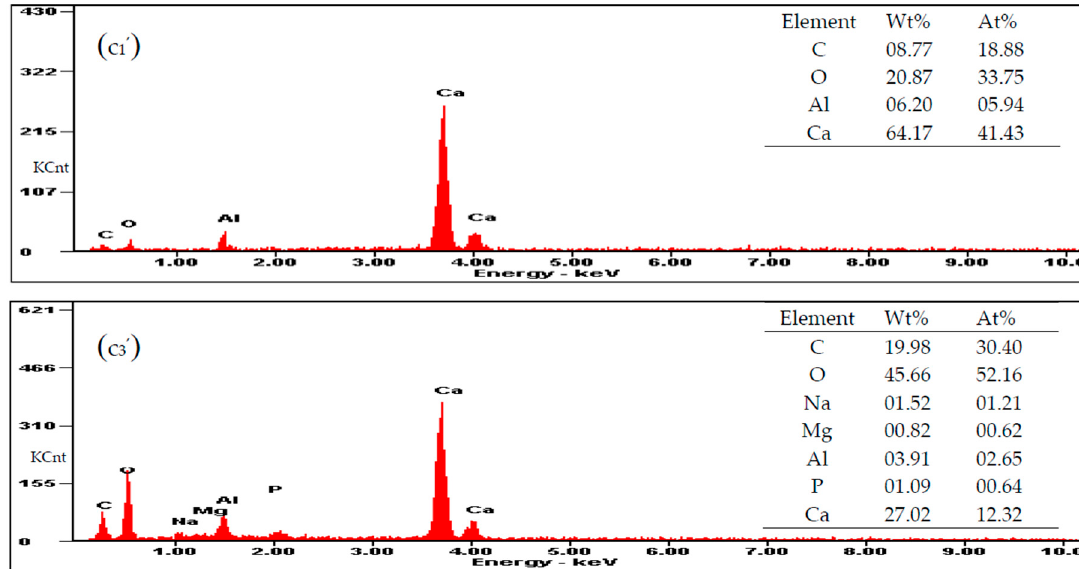
Figure 8. SEM and EDS images of the minerals in control and experimental groups at 15% NaCl and different Mg/Ca molar ratios in MgSO 4 solution after 15 days of cultivation: ( a 1 , a 2 ) Mg/Ca molar ratio of 0 in the control group; ( b 1 , b 2 ) Mg/Ca molar ratio of 2 in the control group; ( c 1 , c 2 ) Mg/Ca molar ratio of 4 in the control group; ( a 3 , a 4 ) Mg/Ca molar ratio of 0 in the experimental group; ( b 3 , b 4 ) Mg/Ca molar ratio of 2 in the experimental group; ( c 3 , c 4 ) Mg/Ca molar ratio of 4 in the experimental group; and ( b 1’ , b 3’ , c 1’ , c 3’ ) EDS analysis of the mineral marked by the red square, respectively.